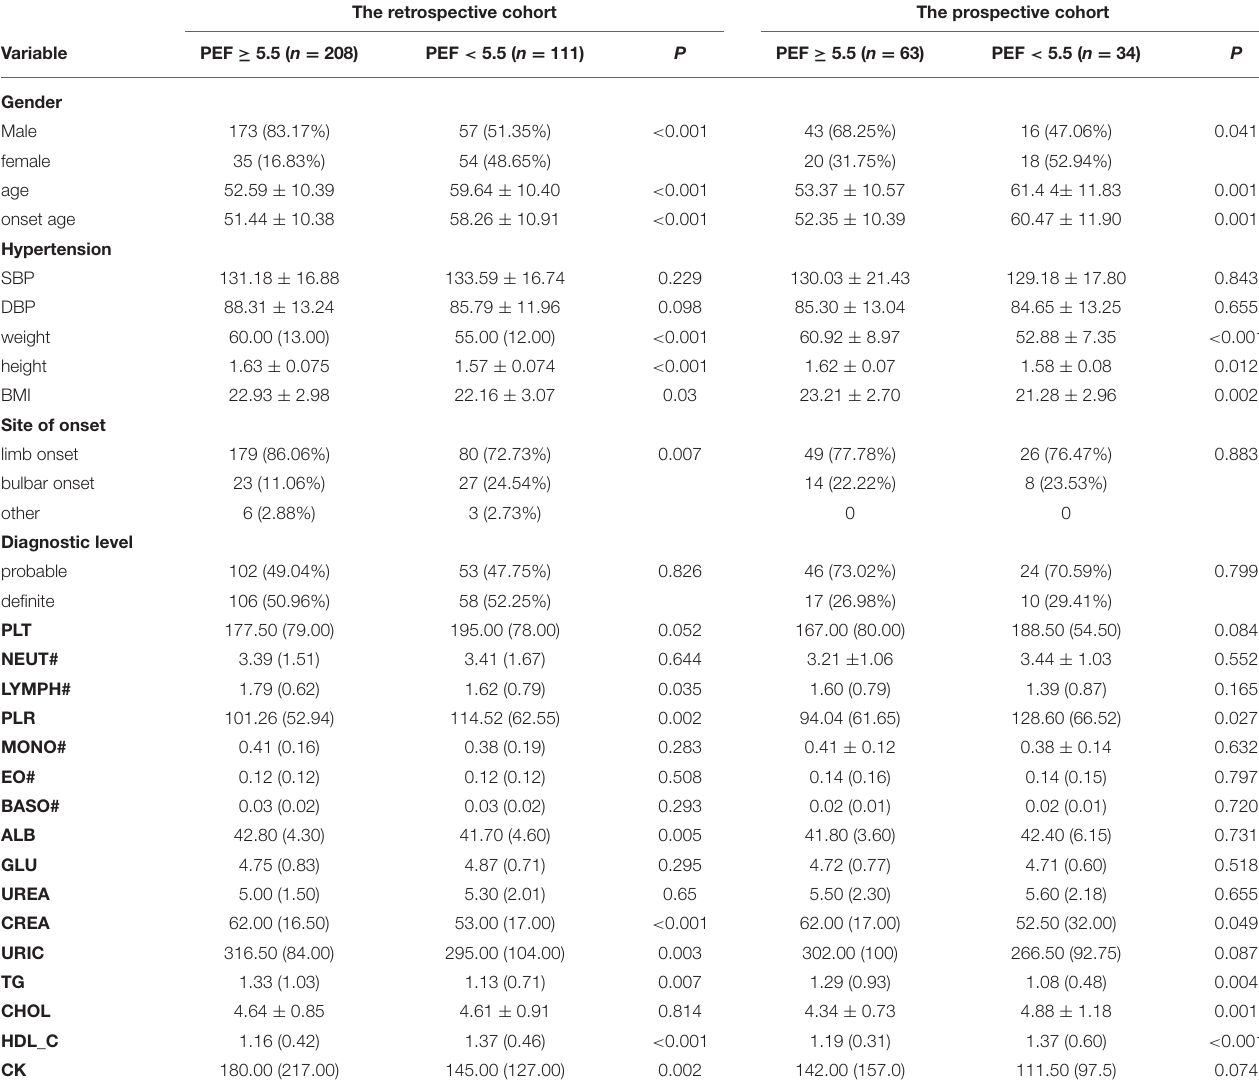
TABLE 1 | Clinicodemographic data of Amyotrophic lateral sclerosis patients stratified by whether their PEF is ≥ 5.50 L/s. The retrospective cohort The prospective